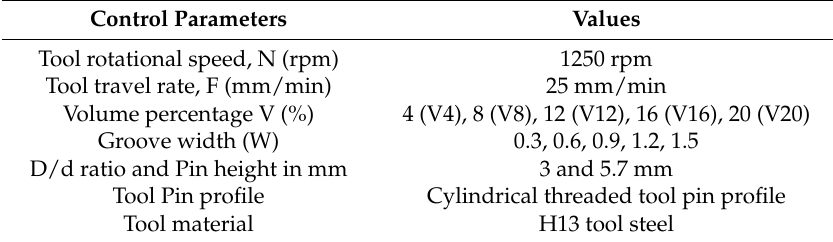
Figure 3. ( a ) FSW process setup with fixture base assembly ( b ) tool plunging and traveling ( c ) Nano-SiC particles dispersion. Table 3. Fraction stir welding (FSW) process parameters used in this